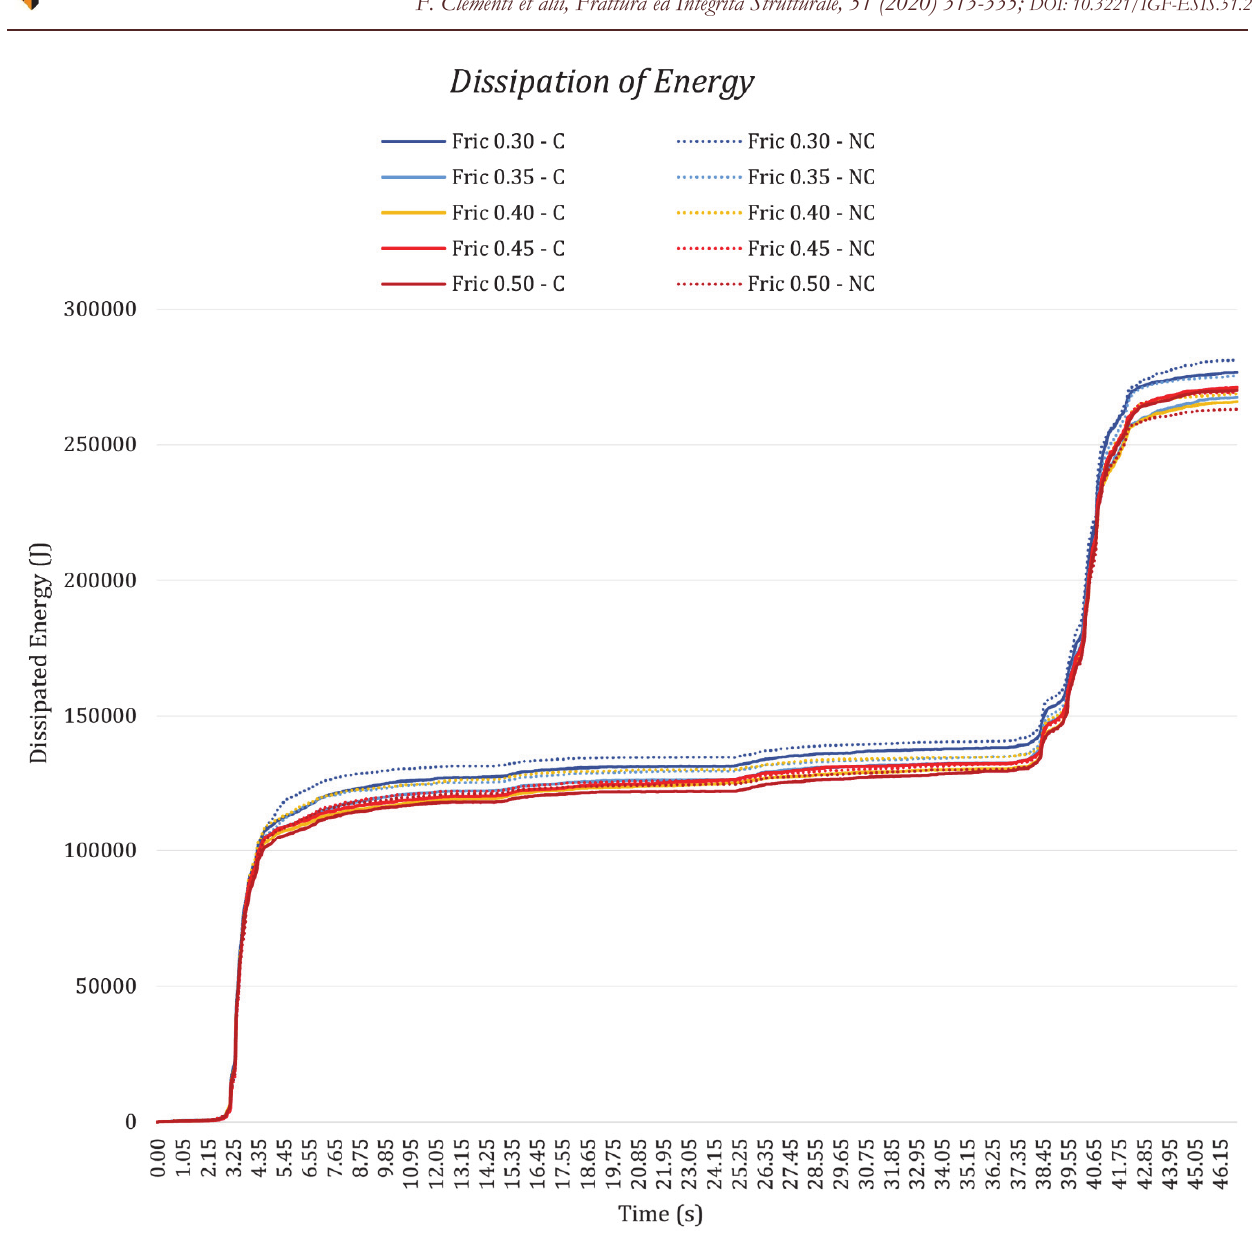
Figure 21: Evolution of the dissipated energy of the civic clock tower of Amatrice (Rieti, Italy) under the four main shocks in the three components x,y,z recorded in the village during the Central Italy seismic sequence of 2016 for both configurations, with (namely C) and without (NC) the steel chains, at varying of the friction on the bell